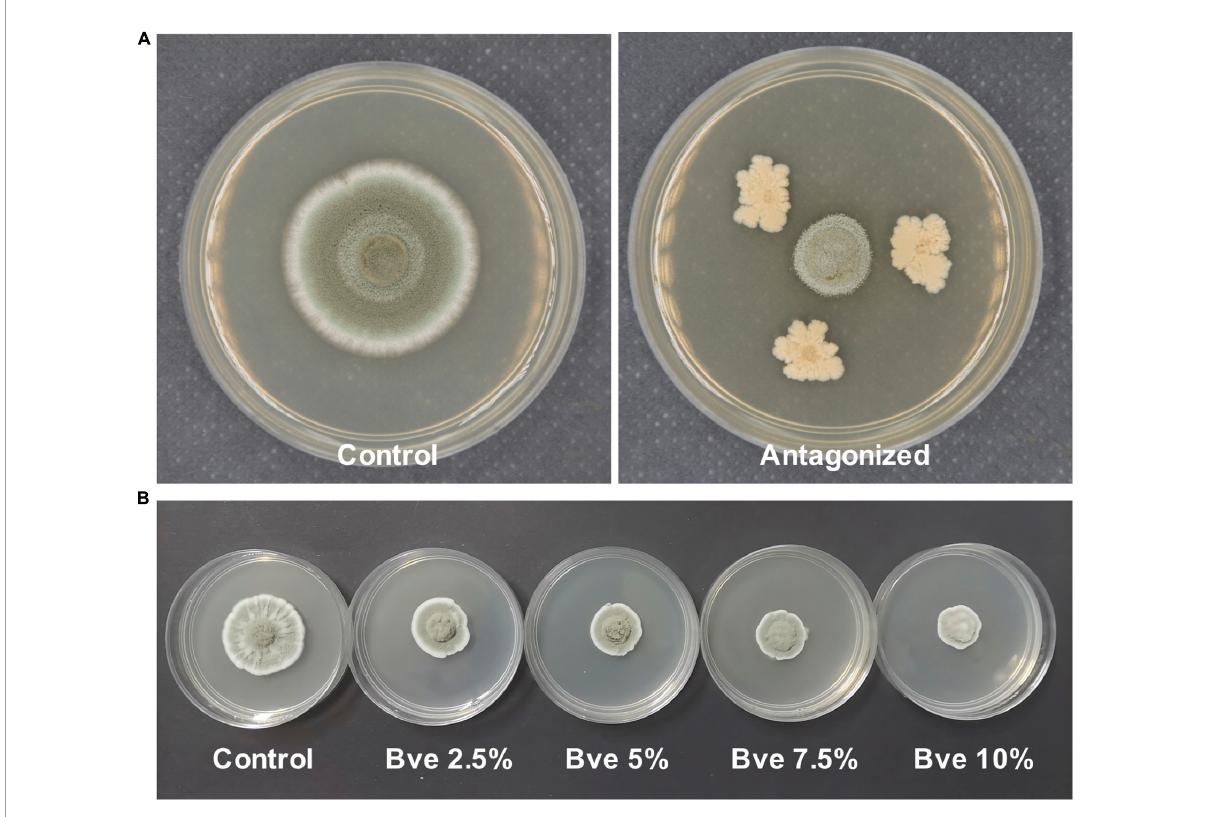
FIGURE10 Morphology of Penicillium olsonii on potato dextrose broth (PDA) after exposure to Bacillus velezensis (5 days after inoculation). Antagonized by B. velezensis on PDA (A) , colony of P. olsonii after exposure to different concentrations of B. velezensis metabolites (B)